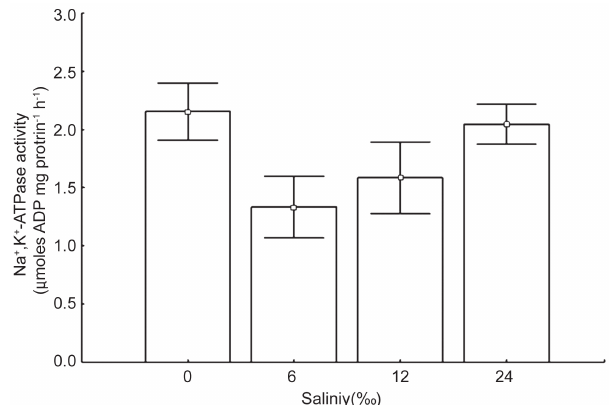
Fig. 1. Gill Na + - K + - ATPase activity in juvenile Lebranche mullet Mugil liza (n = 6) after acclimation to different salinities for 40 days. Data are expressed as mean ± standard error.